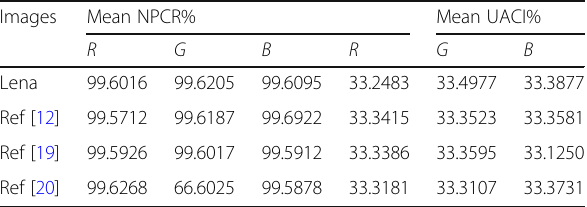
Table 7 Mean values number of pixels change rates and unified average changing intensities of encryption image